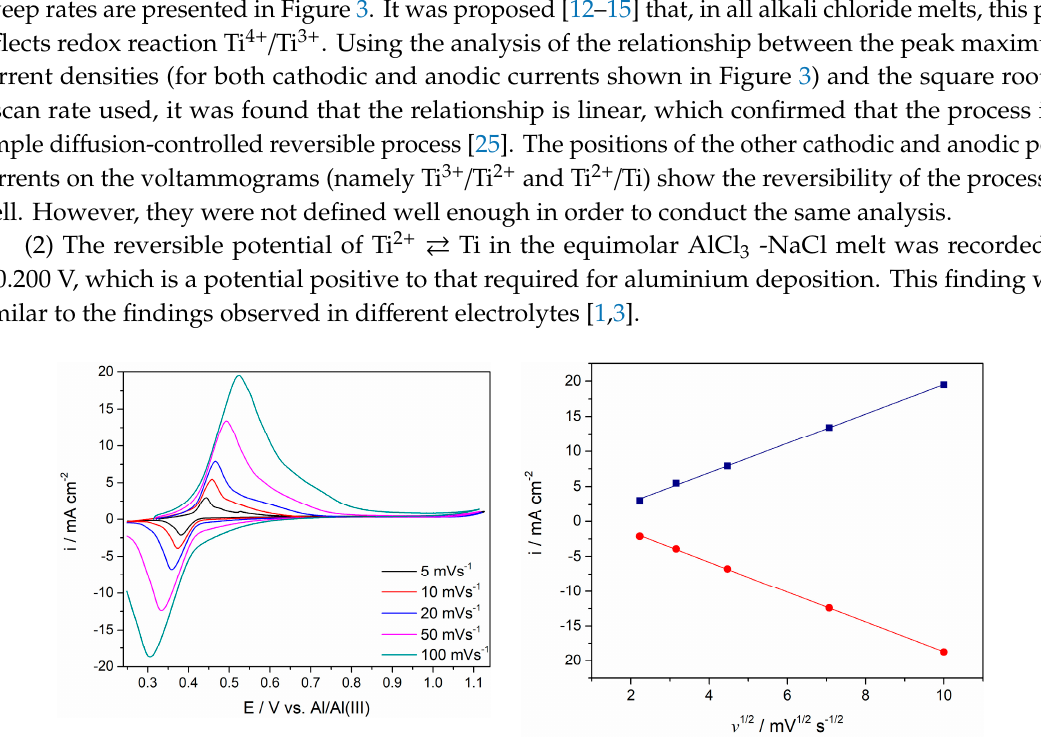
Figure 2. Potentiodynamic polarization curve of the Ti working electrode in the equimolar AlCl 3 -NaCl melt at T = 200 °C, E I = 0.0 V and E F = 1.200 V.